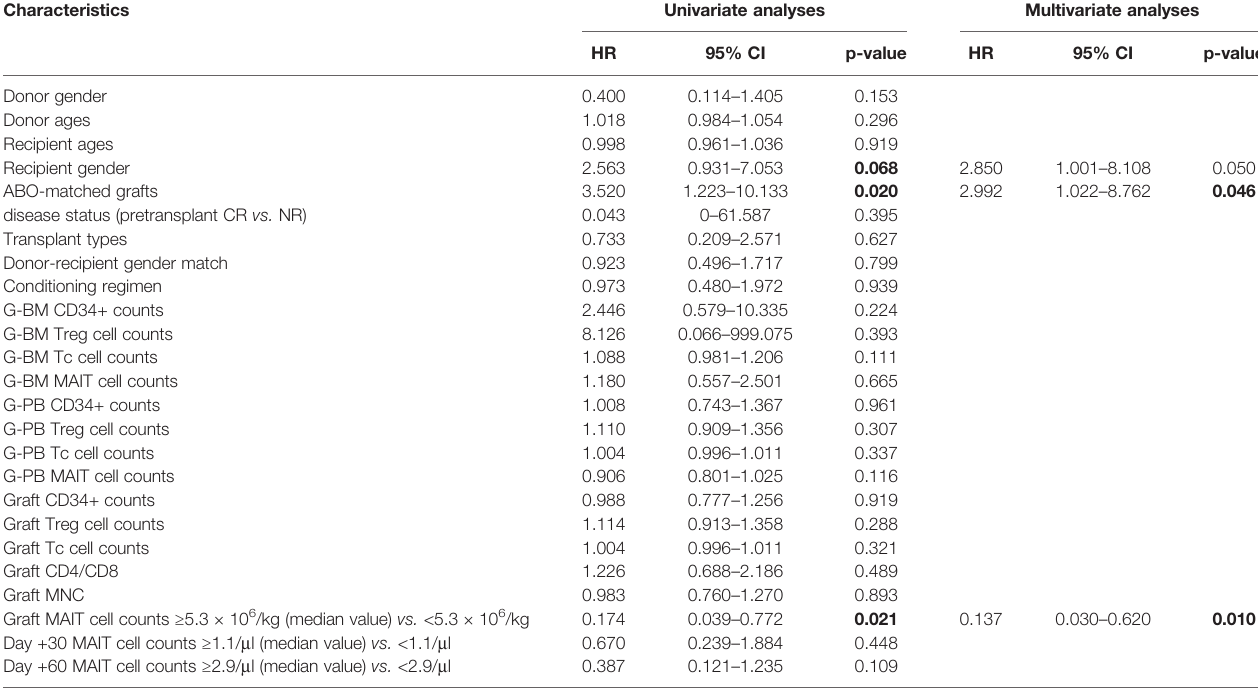
TABLE 1 | Univariate and multivariate analyses of risk factors for the occurrence of gut aGVHD.